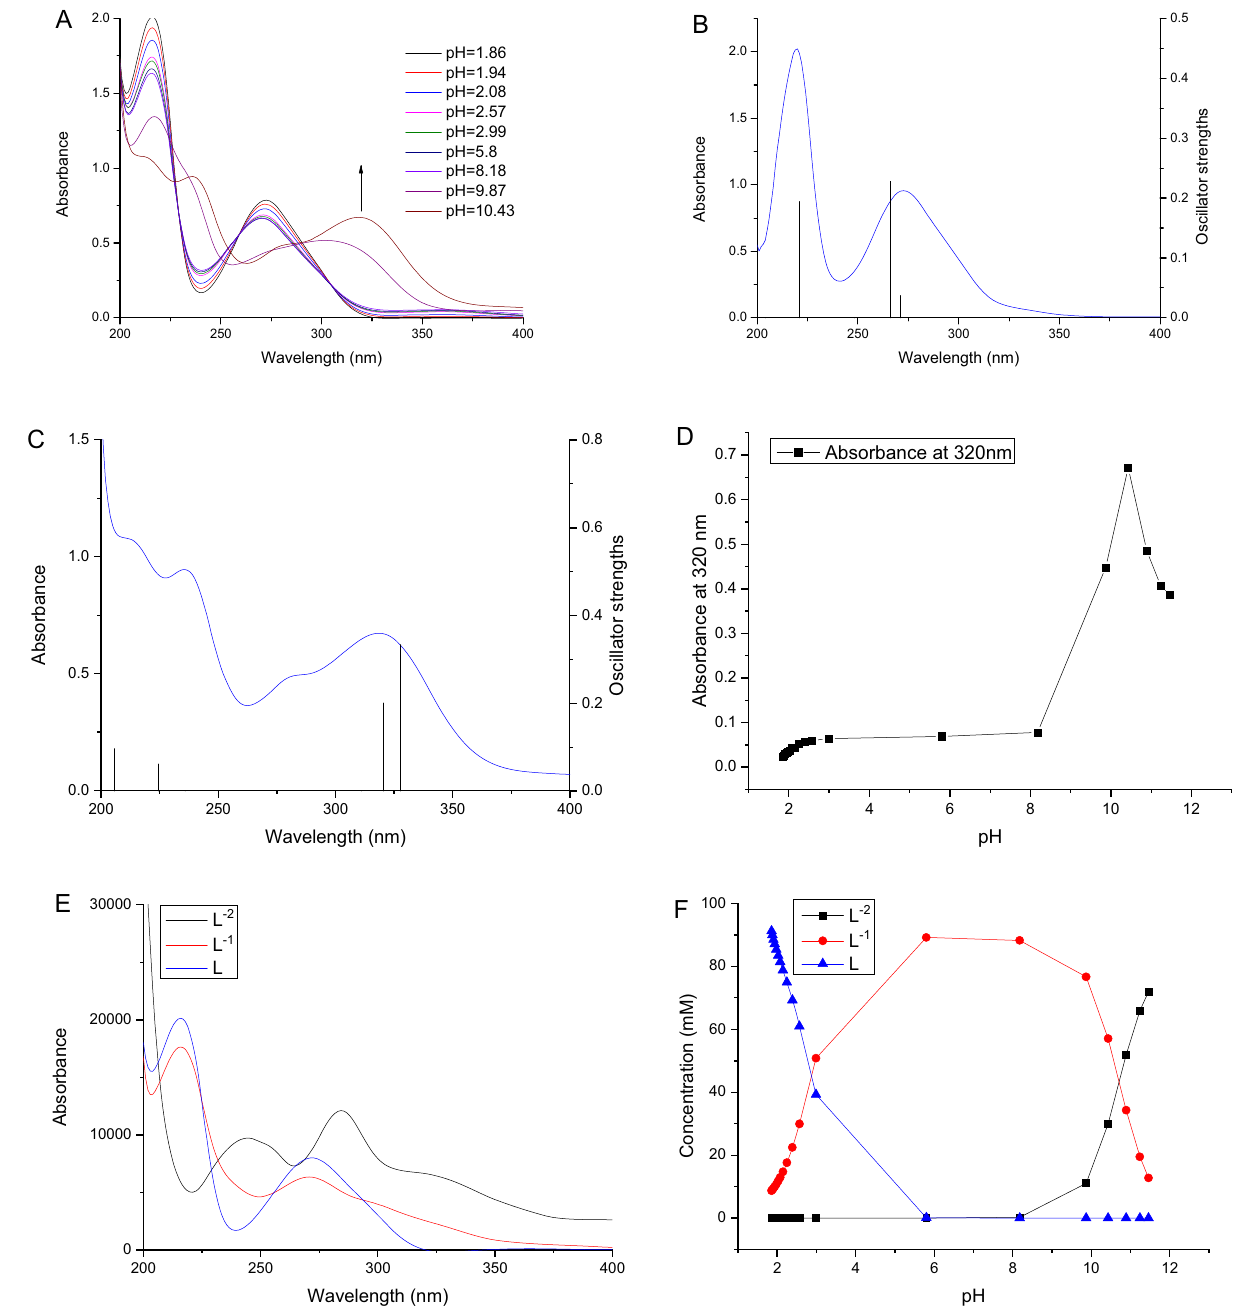
Figure 2. ( A ) UV–vis spectra of propyl gallate (PG) solution continuously titrated with NaOH solution; ( B ) The spectrum of the fully protonated PG was obtained at pH 1.86 (the experimental spectra are shown in blue while the computed energies of transition from the Gaussian calculations are shown as black lines); ( C ) the spectrum obtained at pH 10.43 is compared to the oscillator strength of the 9-OH quinoid PG. ( D ) Changes of absorbance at 320 nm of PG solution with increasing of pH values; ( E ) The characteristic spectra of PG (L) and its two deprotonated species (L −1 , L −2 ) predicted using chemometric modeling method; ( F ) Concentration profiles of protonated PG and its two deprotonated species predicted by the chemometric